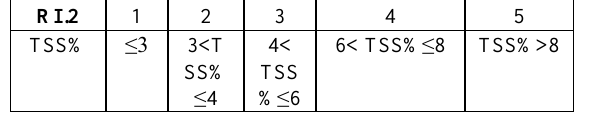
Table 3. Total soluble salts content TSS%